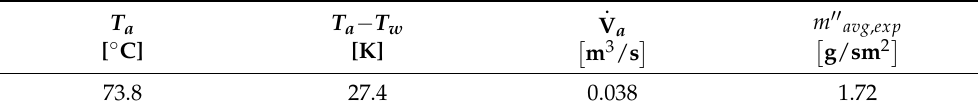
Table A5. Average results obtained from three reference measurements on a commercially available condenser tumble